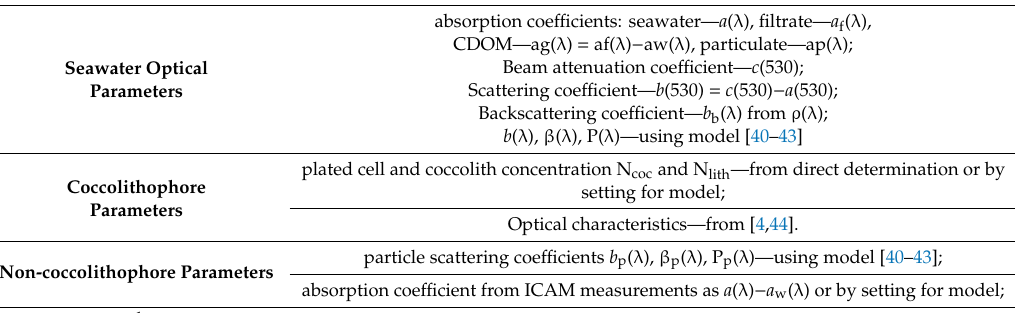
Table 1. Measured and derived parameters 1 for